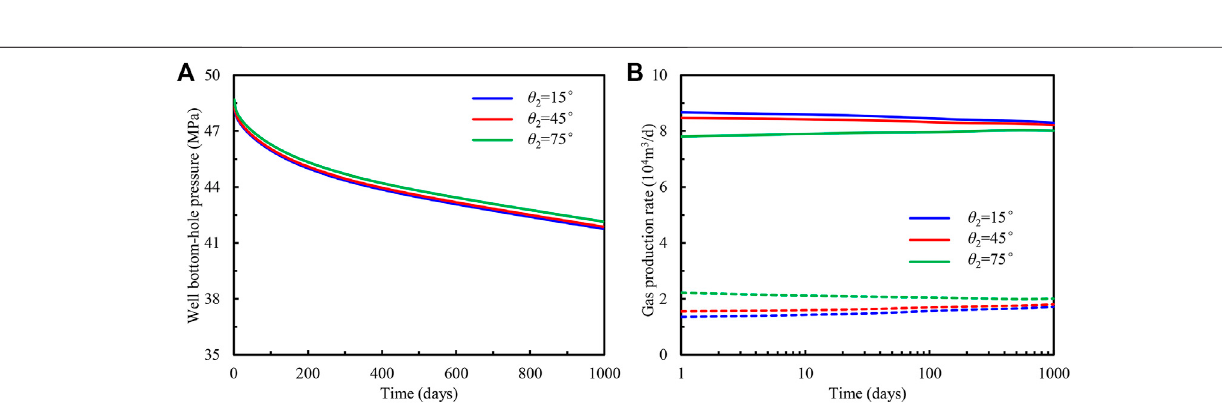
FIGURE 11 | In fl uence of inclination angle in the fi rst layer on (A) well bottom-hole fl owing pressure and (B) gas production rate of an individual layer.